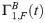
Decoding stimulus class and onset time from a continuous data stream in single trials: Illustration of two electrodes and the continuous classifier using 2 broadband features (subject 2).
(A) Two cortical sites (3 cm from one another) on the fusiform (green) and lingual (orange) gyri are examined. (B) Broadband training templates from the green electrode for faces (blue, 〈B
1(t')〉F) and houses (pink, 〈B
1(t')〉H) are shown on the axes to the left. Testing time course of green electrode broadband spectral change, B
1(t), is shown to the right in black, with the projection of the face template 〈B
1(t')〉F into B
1(t) to produce Γ1,FB(t), shown in the green trace beneath. (C) As in B, but for the orange electrode site, using projections of a house template 〈B
2(t')〉H to produce Γ2,HB(t). (D) The classification feature subspace is defined by back-projection of the templates on the left in (B-C), to obtain training points Γn,SB(q) for face, house, and ISI events at training times τ
q shown. (E) In order to illustrate the multi-dimensional trajectory of the brain state that emerges when different channels and features are brought into a common space, the 2D trace of Γ1,FB(t) from the green electrode (B) versus Γ2,HB(t) from the orange electrode (C), are shown in black in the same subspace as D. The predicted onsets for face (blue) and house (red) stimuli are shown as plus symbols while actual onsets are shown as open circles. Note that the classifier was applied to the entire broadband feature space, not just this 2D subspace. (F) The trajectory of the face onset posterior probability from the classifier Pr{Γ(t)|q → F} (blue) is shown alongside Pr{Γ(t)|q → H} (pink), with predicted (plus symbols) and actual (open circles) times shown.